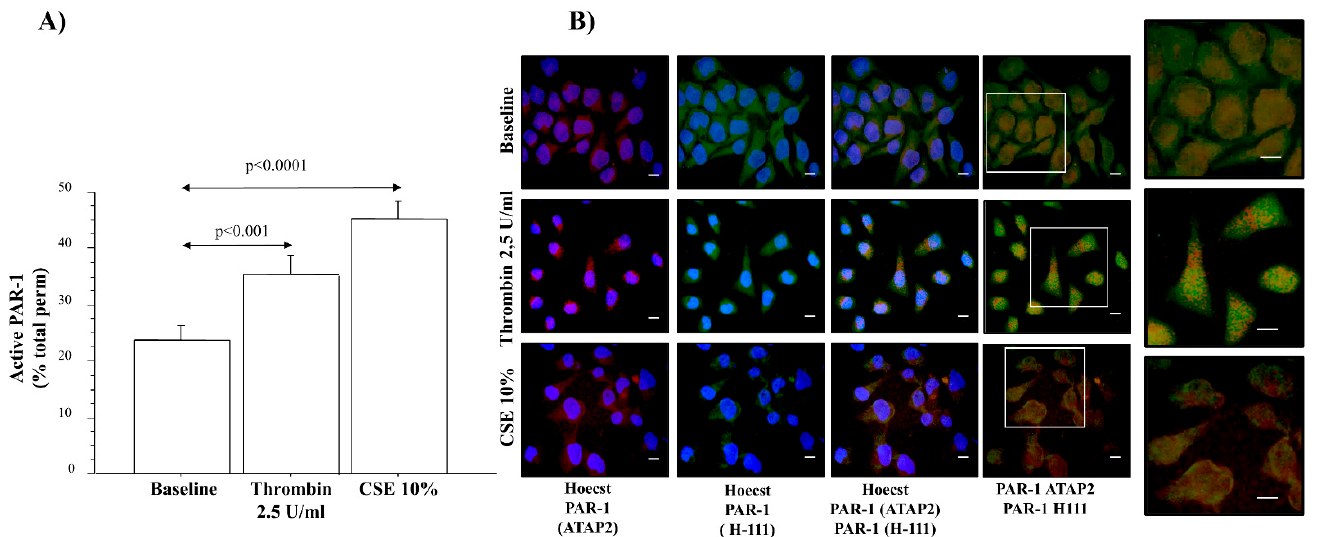
Figure 6. Active PAR-1 in epithelial cell lines. ( A ) 16HBE cells were stimulated with thrombin 2.5 U/mL and CSE 10% to evaluate the activation of PAR-1, using flow cytometric analysis. Bars represent the mean ± S.D. of fluorescence intensity of three separate experiments. The results shown are the differences between the percentage of total counts obtained with anti-PAR-1 ATAP-2 Ab and anti-PAR-1 H-111 Ab (see the Materials and Methods section). Statistical analysis was performed by Student’s t -test. Significance was set at p < 0.05. ( B ) Anti-PAR-1 ATAP-2 ab, and anti-PAR-1 H-111 ab localization and colocalization/distribution in 16HBE stimulated with thrombin at 2.5 U/mL and CSE 10%, tested by immunofluorescence analysis. The representative immunofluorescence analysis is shown. The scale bar is 50 µm. The magnification shows the area of the co-localization/distribution of anti-PAR-1 ATAP-2 and PAR-1 H-111 Abs immunofluorescent staining.